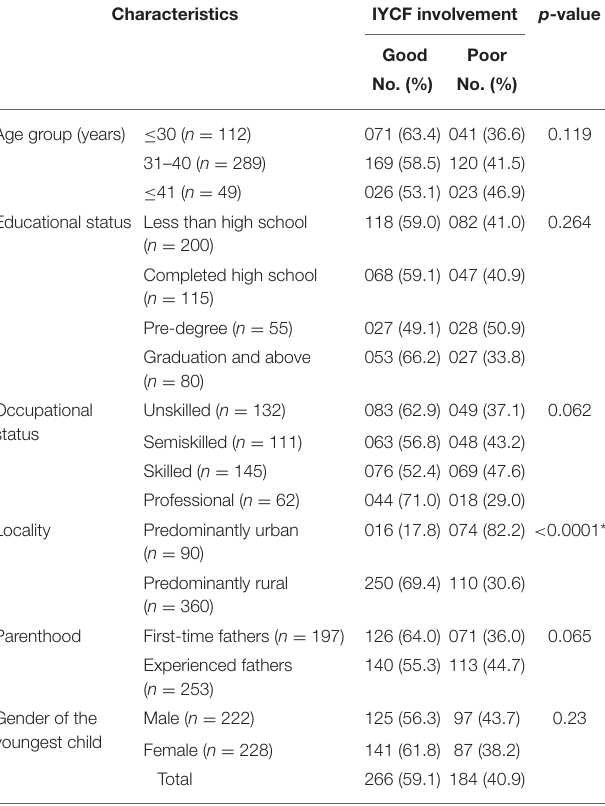
TABLE 4 | Practices of the study participants related to IYCF ( N = 450). Practices